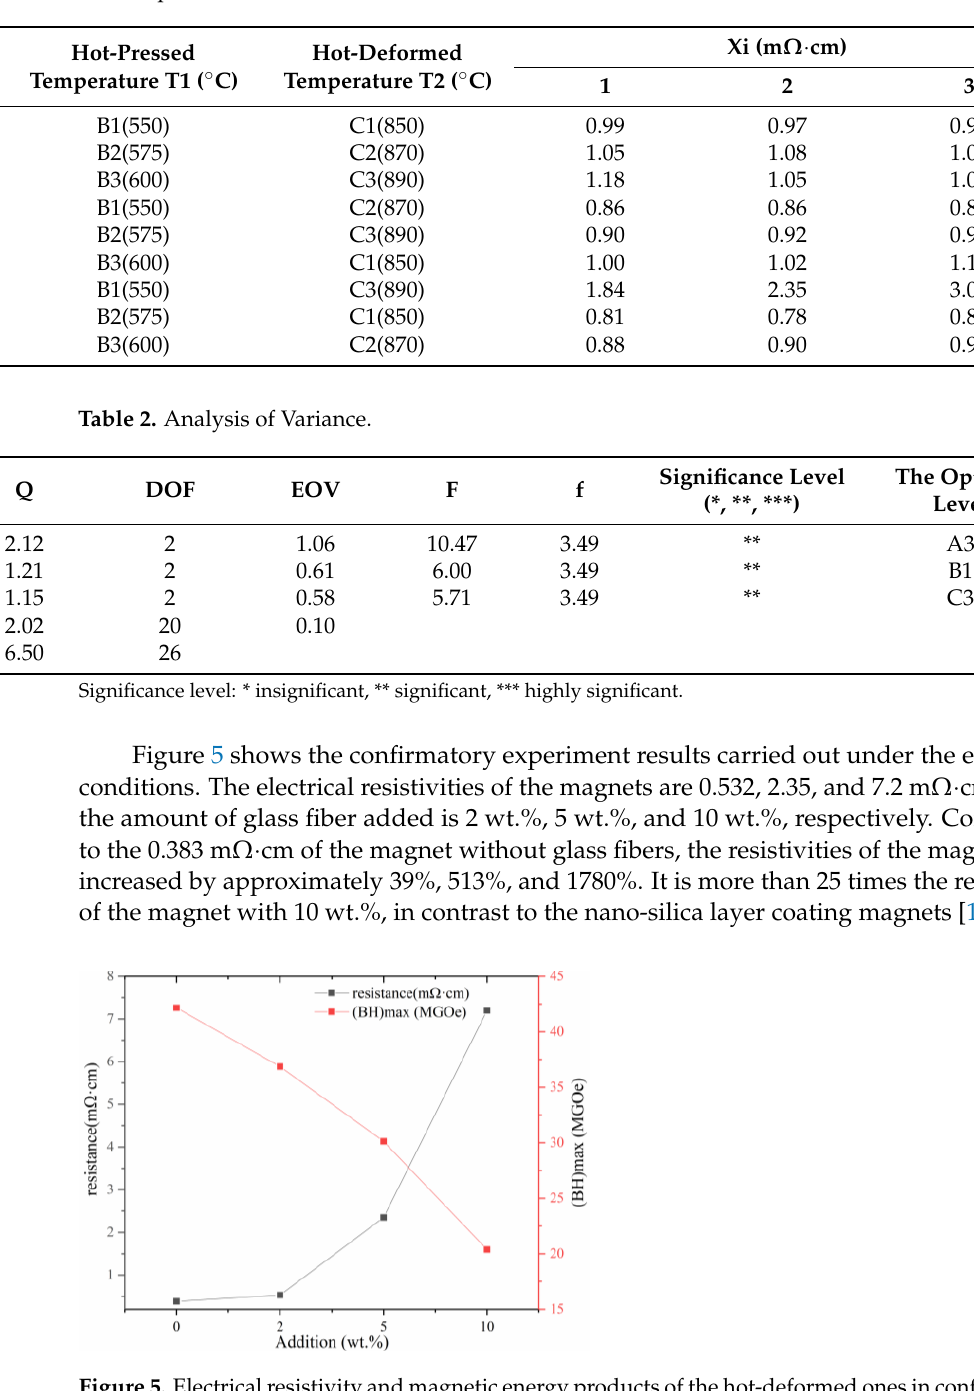
Table 1. Resistivity of hot-pressed permanent magnets with different mass fractions of glass fiber-doped.